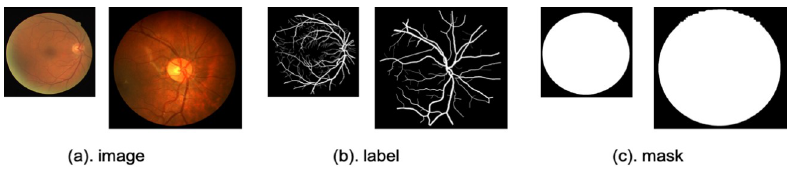
Fig 5. Samples of the retinal fundus images and their H × W dimensions in pixels. (a) Input images: Left: DRIVE (584 × 565); right: CHASE_DB1 (960 × 999). (b) Manual annotation of the retinal vessels. (c) Binary segmentation masks of the fundus